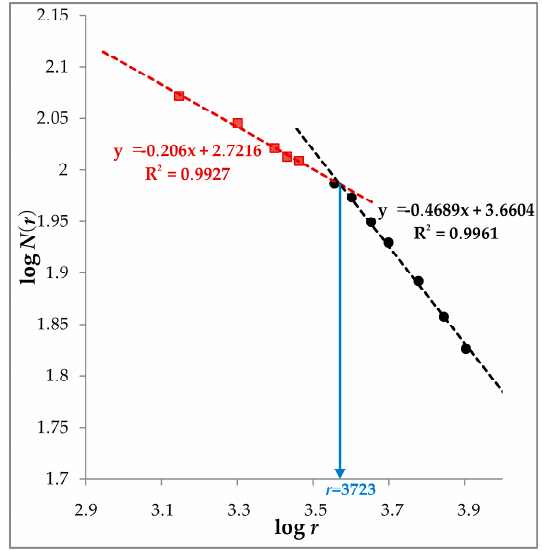
Figure 8. Log–log plot of box number N ( r ) versus box size r for tungsten occurrences.